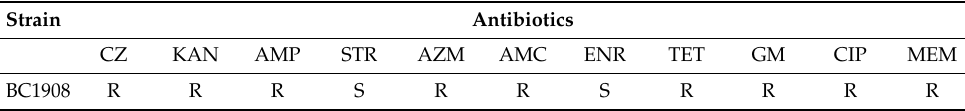
Table 2. Antimicrobial susceptibility profile of